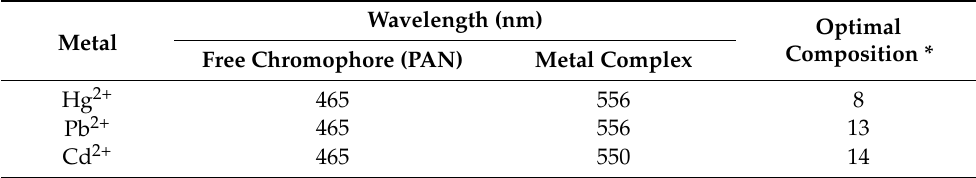
Table 5. Summary of the optimization results for the membranes prepared with PAN using M2 in the determination of Hg(II), Pb(II), and Cd(II).